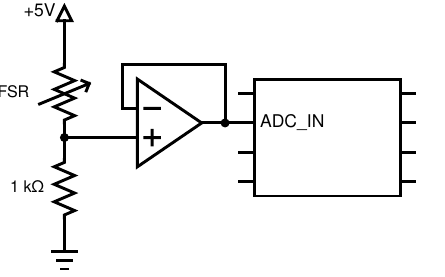
Figure 2. FSR connection to the MCU ADC input (the same for each sensor).